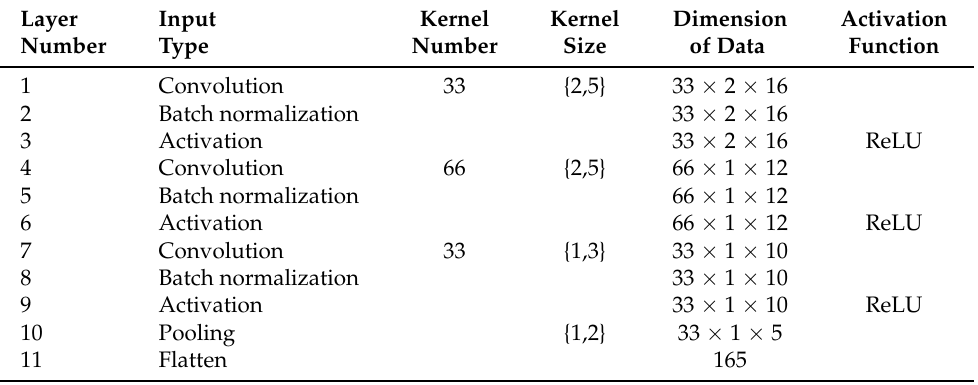
Table 1. Convolution segment